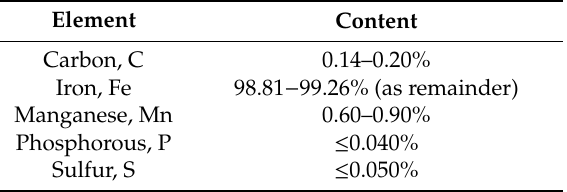
Table 7. The chemical composition of a mild steel coupon AISI 1018 mild / low carbon steel strip COSASCO’s, Rohrback Cosasco Systems,